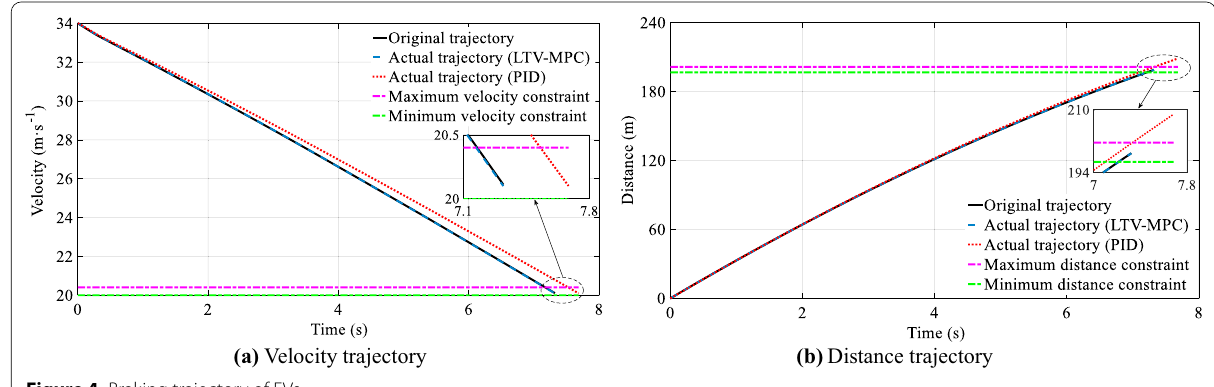
Figure 4 Braking trajectory of EVs